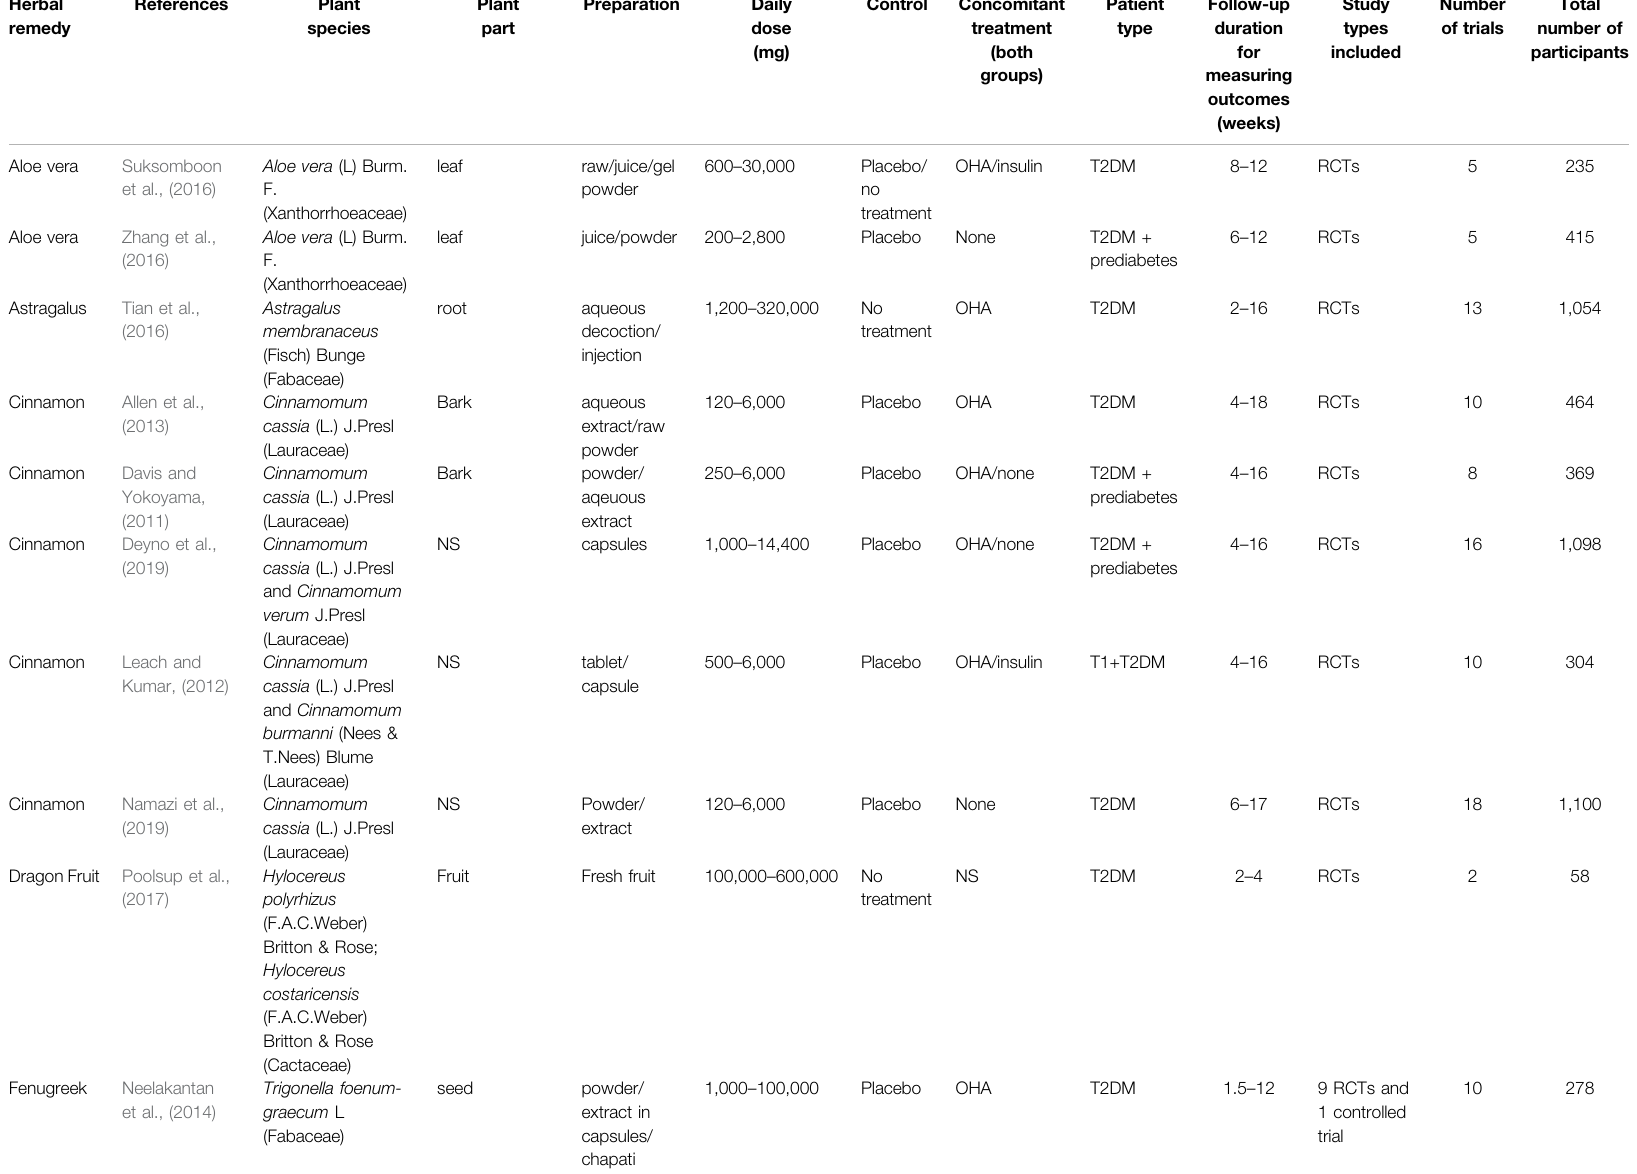
TABLE 1 | Characteristics of included